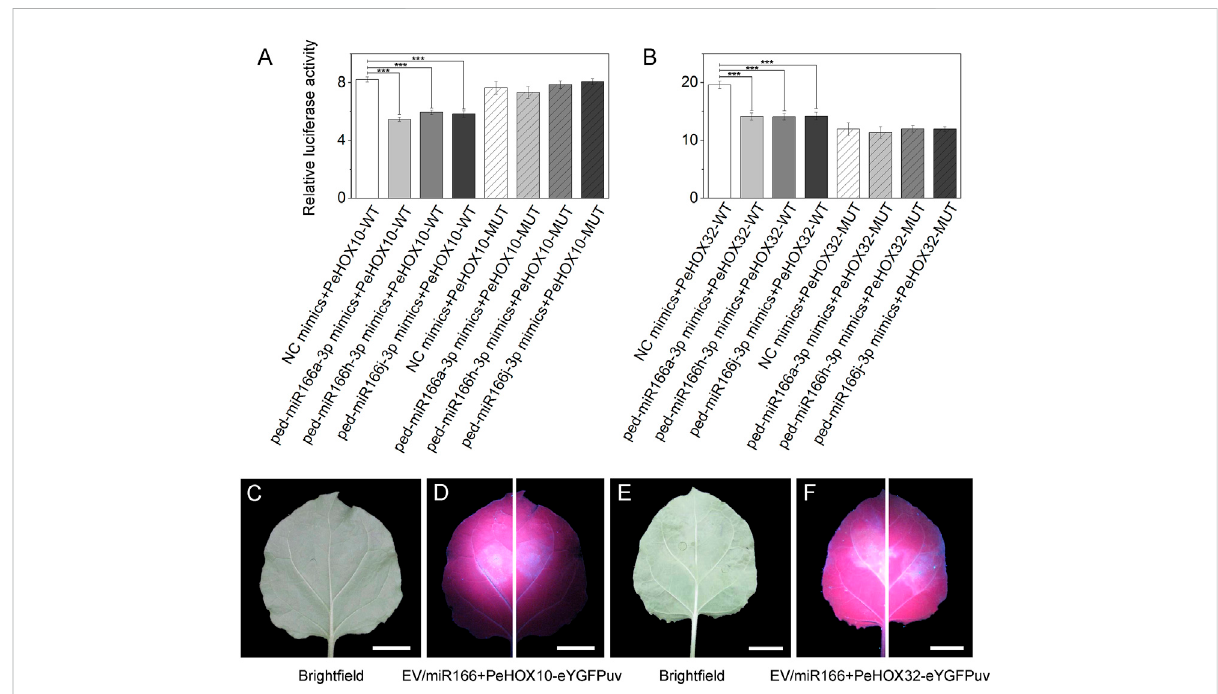
FIGURE 6 Veri fi cation of the correlation between three miR166s and two target genes using dual-luciferase reporter and transient expression assays. (A – B) Dual-luciferase reporter assays con fi rmed that miR166s are bound to PeHOXs . The three miRNAs were ped-miR166a-3p, ped-miR166h-3p, and ped-miR166j-3p. The two target genes were PeHOX10 ( PH02Gene00975 ) and PeHOX32 ( PH02Gene31932 ). Error bars indicate the standard deviations of three technical repeats. The signi fi cance of differences among groups was determined using t -tests. * p < 0.05; ** p < 0.01; and *** p < 0.001. (C – F) Transient expression assays con fi rmed that miR166s are bound to PeHOXs . Differential fl uorescence intensity was observed between two sides of the same leaf under the UV light, where an empty vector (EV)/miR166 + PeHOXs-eYGFPuv was injected. Bar = 1